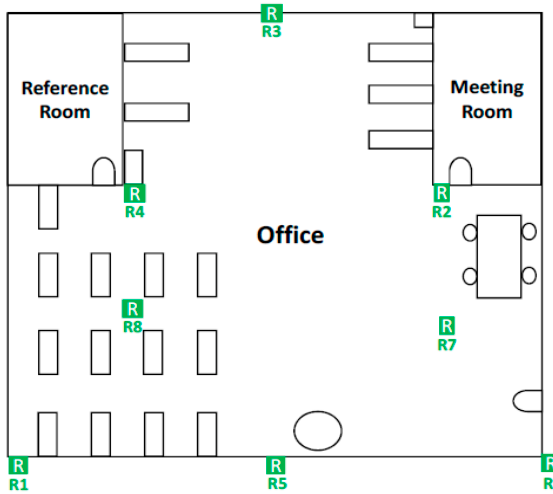
Figure 19. Configuration of testing device for BLE receiver.